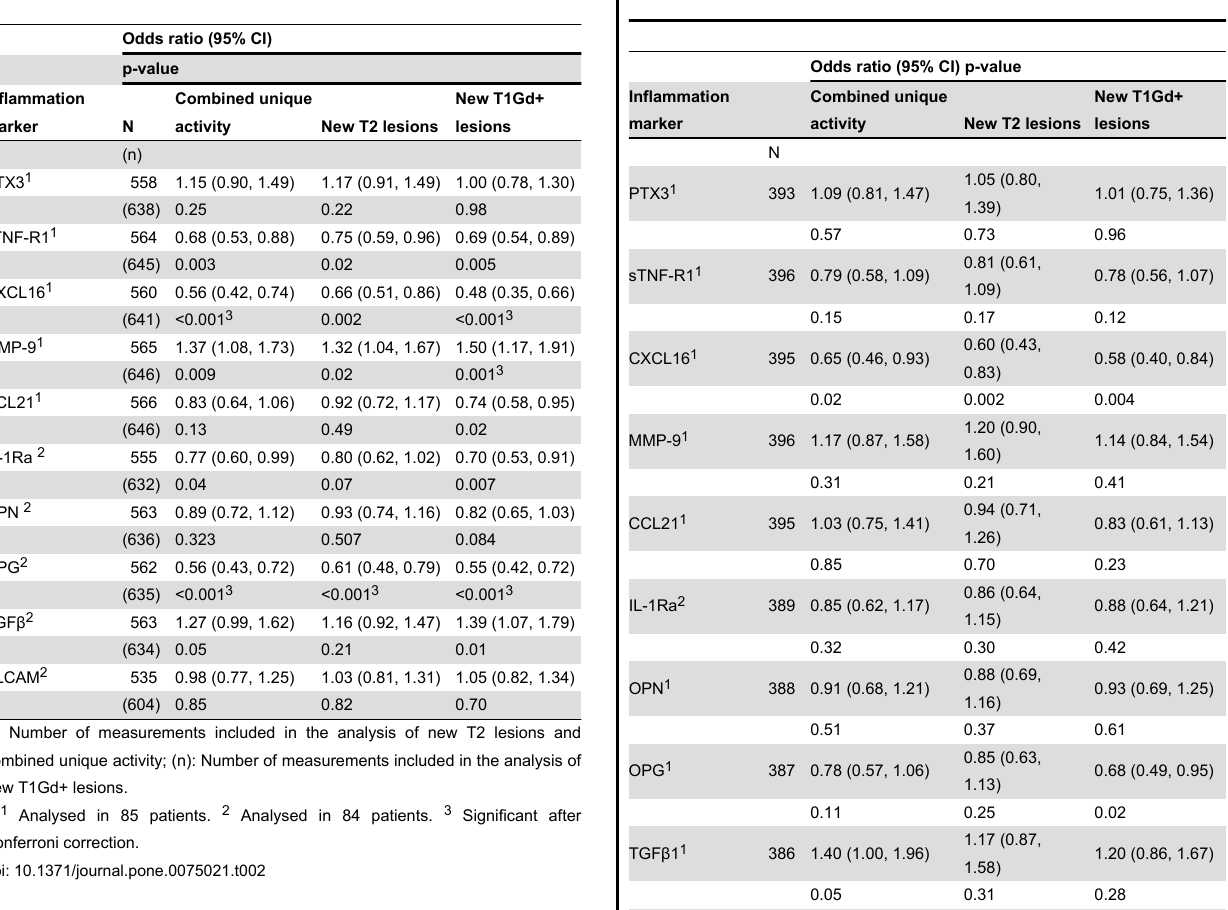
Table 2. Odds ratios for simultaneous MRI activity for each 1 SD increase in each inflammation marker.